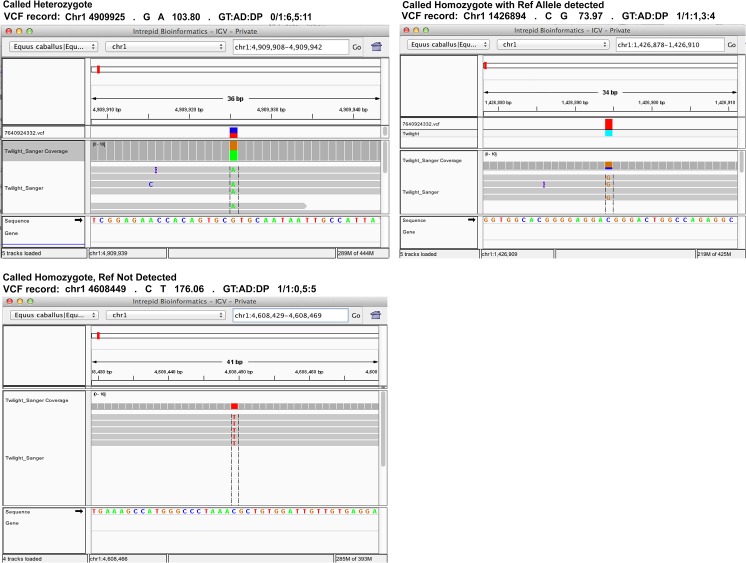
Variant Call Format Records.An example of three variant call format records. The first is a called heterozygote with an allele depth of 11, 6 reads containing the reference allele, and 5 reads containing the non-reference. The second, a called homozygote in the current analysis with an allele depth of 4, three high quality reads containing the non-reference allele and one low quality read containing the reference. The third, is an example of a called homozygote with an allele depth of 5, where all 5 reads contained the non-reference allele. Images of the reads used to derive the VCF records are shown within the IGV Browser. Base calls within the reads that agree with the reference are not rendered.